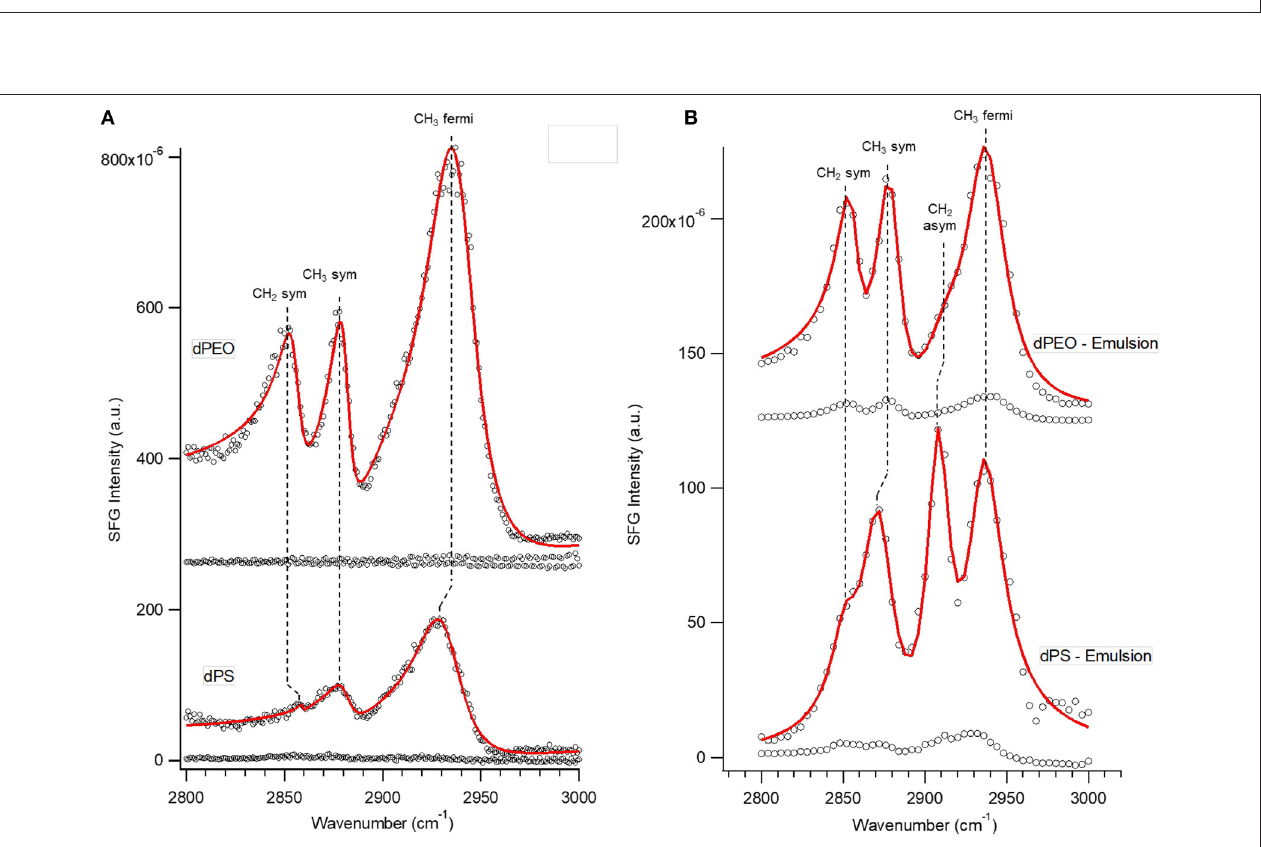
FIGURE 2 | SFG spectra in the C-H stretching region and SSP polarization combination of (A) natural beetle Coccinella septempunctata tarsal fluid on PEO and PS substrates and (B) biomimetic emulsion on PEO and PS substrates. Three vibrational modes were observed in all four spectra: near 2,855, 2,880, and 2,935 cm − 1 corresponding to CH 2 symmetric, CH 3 symmetric, and CH 3 Fermi vibrational modes, respectively. One mode is unique to the biomimetic emulsion/substrate interfaces, the CH 2 asymmetric stretch near 2,914 cm − 1 , likely due to different orientation of surface hydrocarbons between natural and biomimetic fluids. Relative SFG intensity of CH 3 and CH 2 symmetric modes and the change in this intensity as hydrophobicity is increased is similar between natural and biomimetic fluid interfaces.